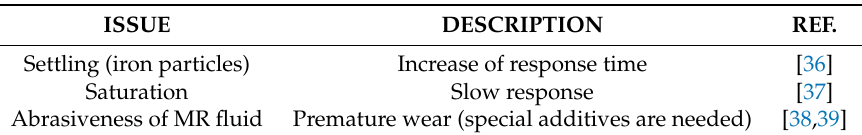
Table 2. Examples of drawbacks in MR damping